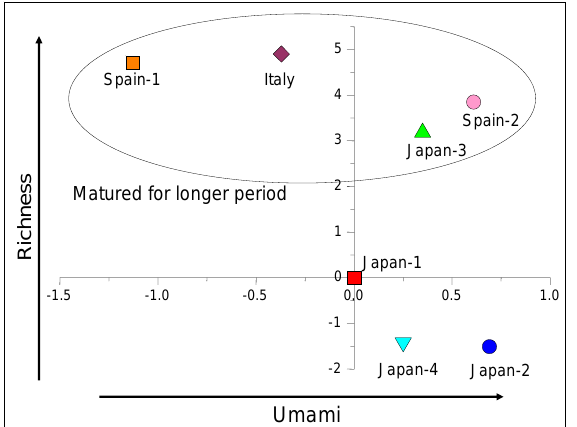
Figure 18. Taste map of Prosciutto ham. Four samples from Japan, two from Spain and one from Italy were measured. Each was mixed with the same amount of pure water and then stirred with a mixer for 1 minute. The solution was filtered through gauze and the filtrate measured as the